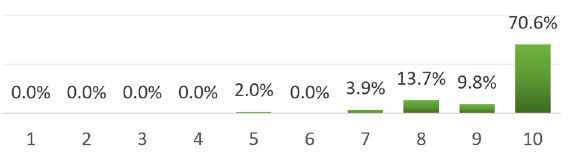
Figure 9. Is the way of visualizing forces with LED strips clear? (1—no, 10—very).